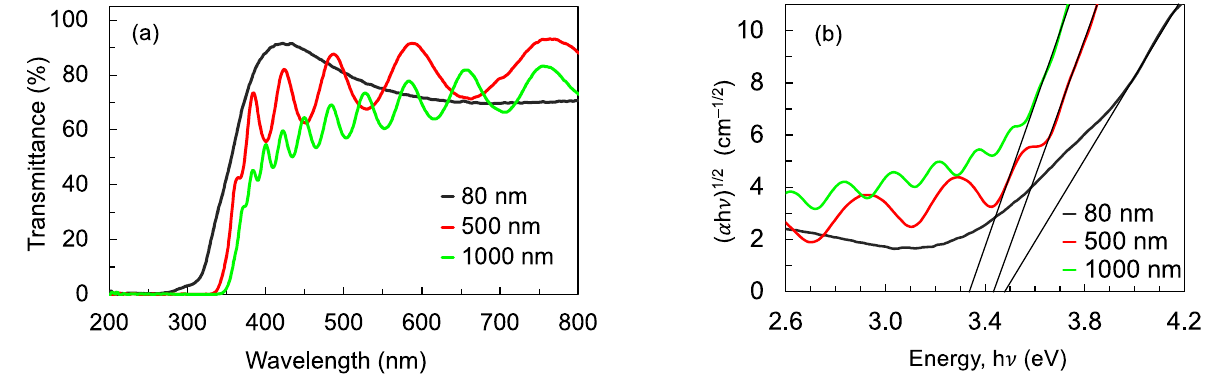
Figure 8. ( a ) Transmission spectrum; ( b ) Tauc plot showing the optical band gap of the TiO 2